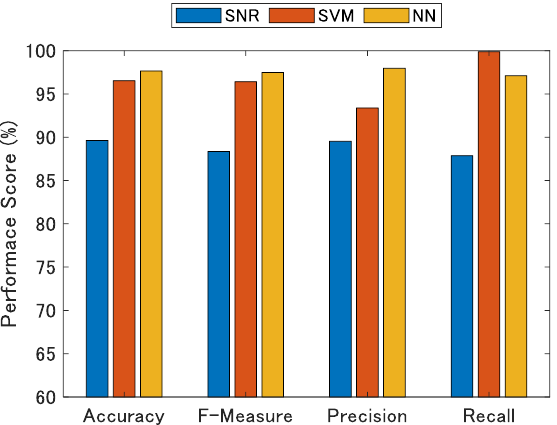
Figure 15. Performance of NLOS classifiers using SNR, SVM, and